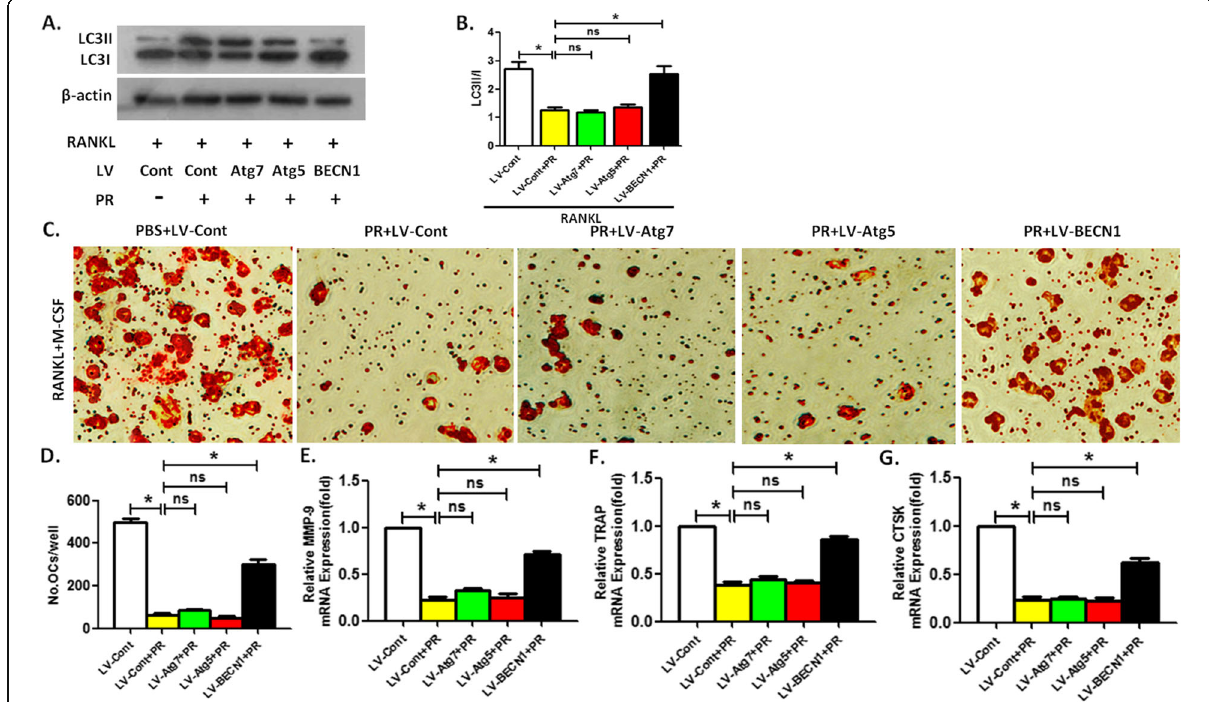
Fig. 4 Under RANKL intervention, BECN1 overexpression reverses Puerarin-inhibited OCP autophagy and osteoclast differentiation. a - b LC3II/I in viruses-transduced OCPs treated with Puerarin (50 μ M) along with RANKL for 6 h was detected by Western Blotting. Compared between Group LV-Cont and Group LV-Cont+PR, Group LV-Cont+PR and Groups LV-Atg5/BECN1/Atg7+ PR in the presence of RANKL, respectively, *P < 0.05. c Typical TRAP staining of mature osteoclasts derived from viruses-transduced OCPs under the joint intervention of M-CSF, RANKL and Puerarin for 5 days. Scale bar, 100 μ m. d The quantitative results regarding TRAP + multinucleated cells in C. e - g mRNA expression of MMP-9, TRAP or CTSK in OCPs treated with indicated treatments. Data are presented as mean ± SEM from three independent experiments. Compared between Group LV- Cont and Group LV-Cont+PR, Group LV-Cont+PR and Groups LV-Atg5/BECN1/Atg7+ PR in the presence of RANKL plus M-CSF, respectively, *P < 0.05. ns, no significance; PR,